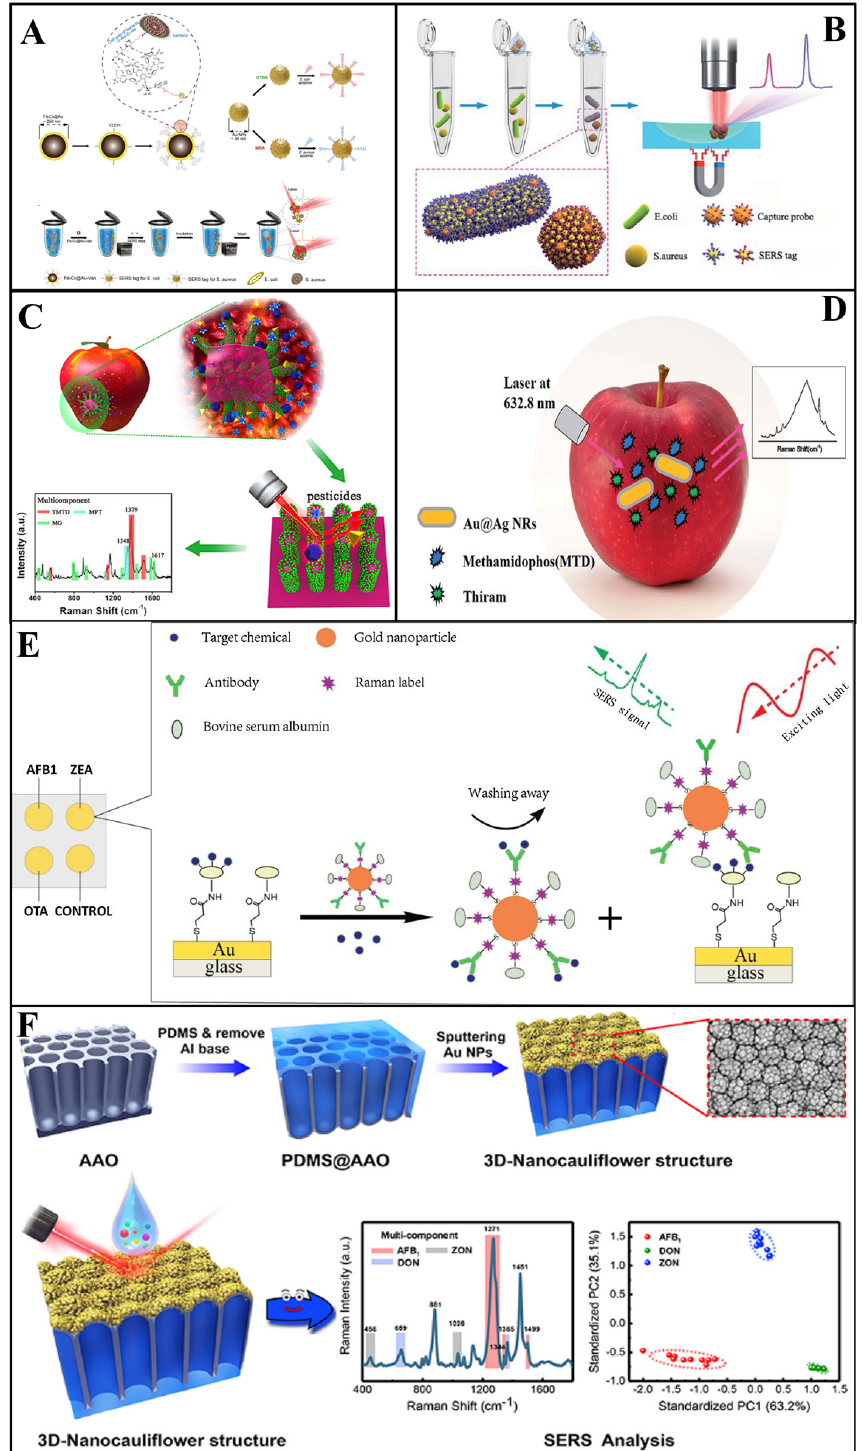
Figure 4. ( A ) Schematic illustration of the synthesis of a vancomycin − modified SERS platform [65] . ( B ) Schematic illustration of the SERS − based sandwich immunoassay platform [54]. ( C ) Schematic demonstration of the preparation of a G–SERS substrate [84]. ( D ) Schematic illustration of the simultaneous detection of thiram and methamidophos [85]. ( E ) Schematic demonstration of a multiplex SERS − based immunosensor [98]. ( F ) Schematic demonstration of the 3D nanocauliflower substrate [99] .